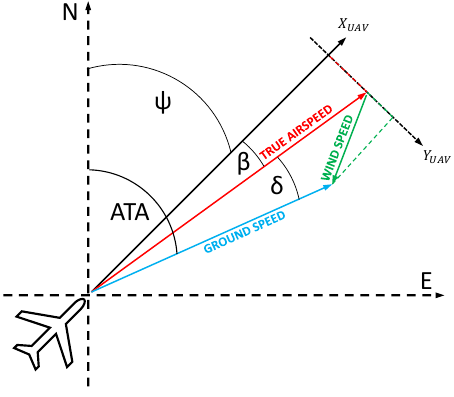
Figure 1. Formation of the expanded wind triangle; the figure includes the sideslip angle β . This angle is nonzero when for example the aircraft is not flying straight ahead relative to the aircraft coordinate system, the reference system is not well aligned or turbulent wind fluctuations are